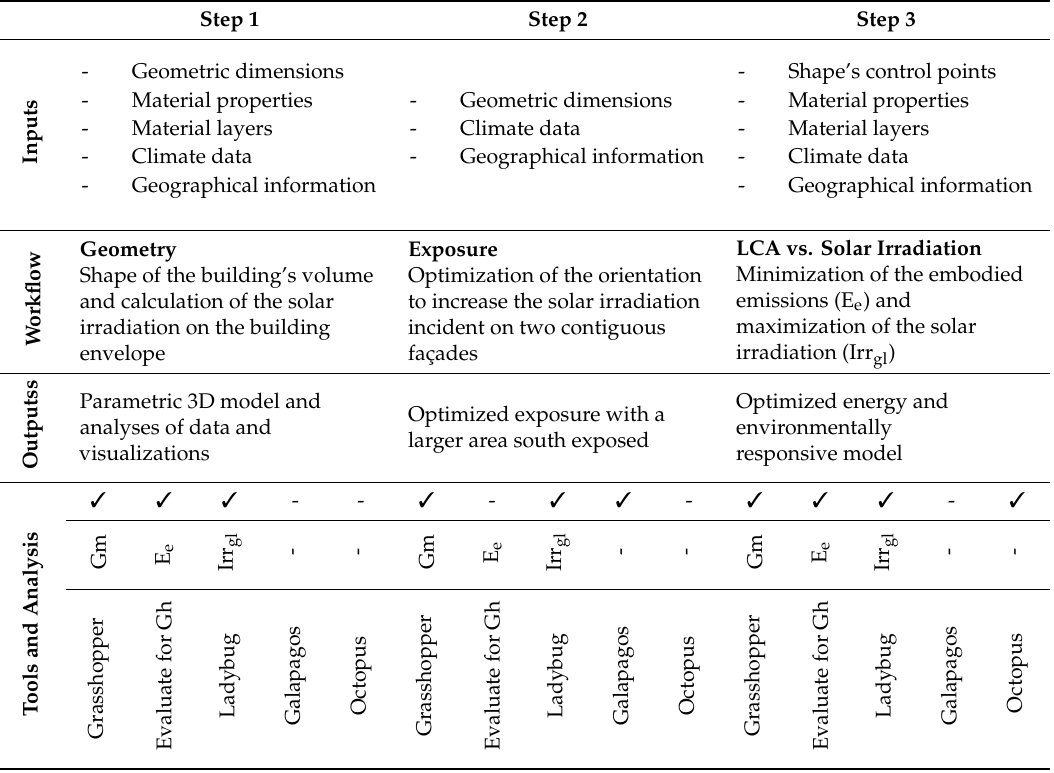
Table 2. Overview of the